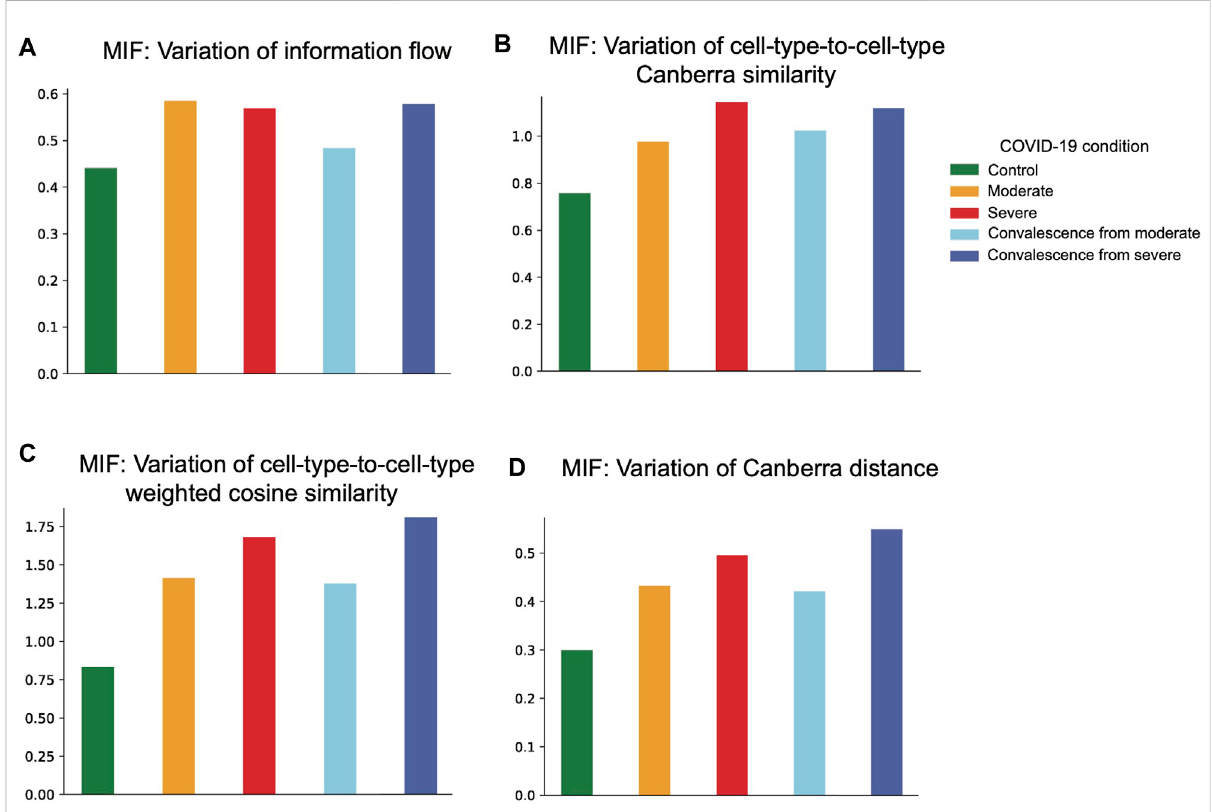
FIGURE 5 Networkvariabilitybasedonfourdistance measures. (A) Networkvariabilitybasedoninformation fl owdistance.Thevariabilityinmoderateand severe groups is higher than that in the control group. The variability in the severe convalescence group is higher than that in the moderate convalescencegroup. (B) Networkvariabilitybasedoncell-type-to-cell-typemodi fi edCanberradistance.Thereisanincreasingpatternofvariability from control to moderate to severe groups and from moderate convalescence to the severe convalescence group. (C) Network variability based on cell-type-to-cell-type weighted cosine similarity. There is an increasing pattern of variability from control to moderate to severe groups and from moderate convalescence to the severe convalescence group. (D) Network variability based on graph-to-graph modi fi ed Canberra distance. There is an increasing pattern of variability from control to moderate to severe groups and from moderate convalescence to the severe convalescence